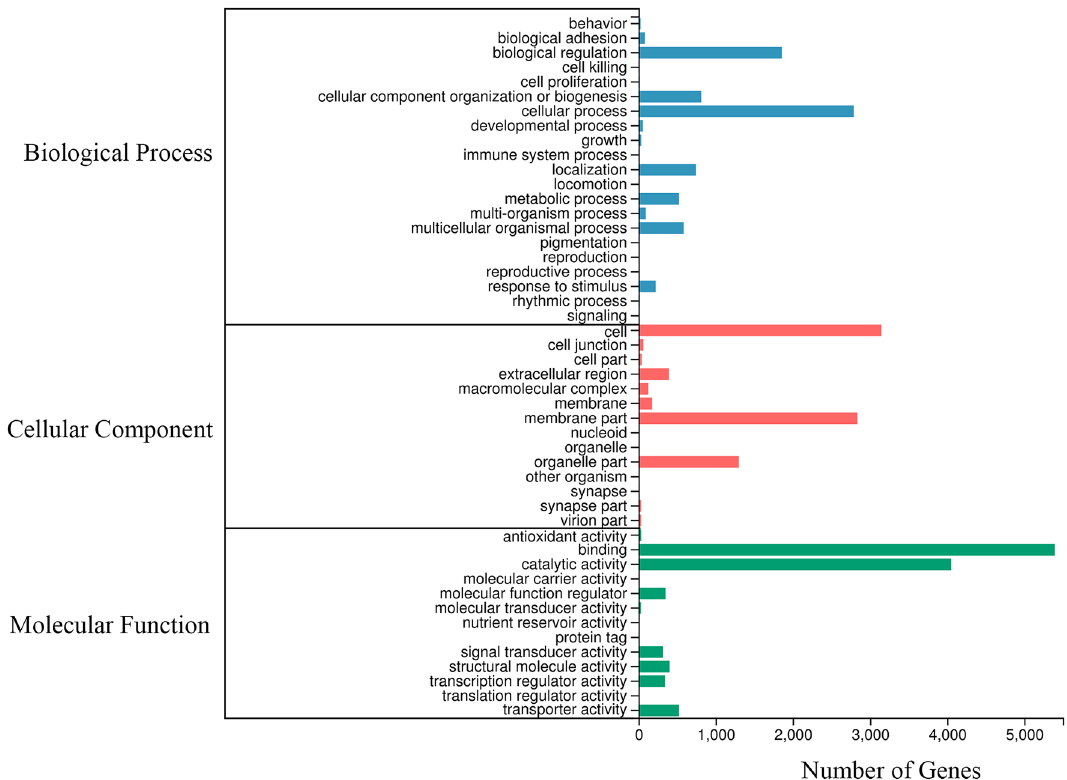
Figure 3. Clusters of GO categorizations of all annotated